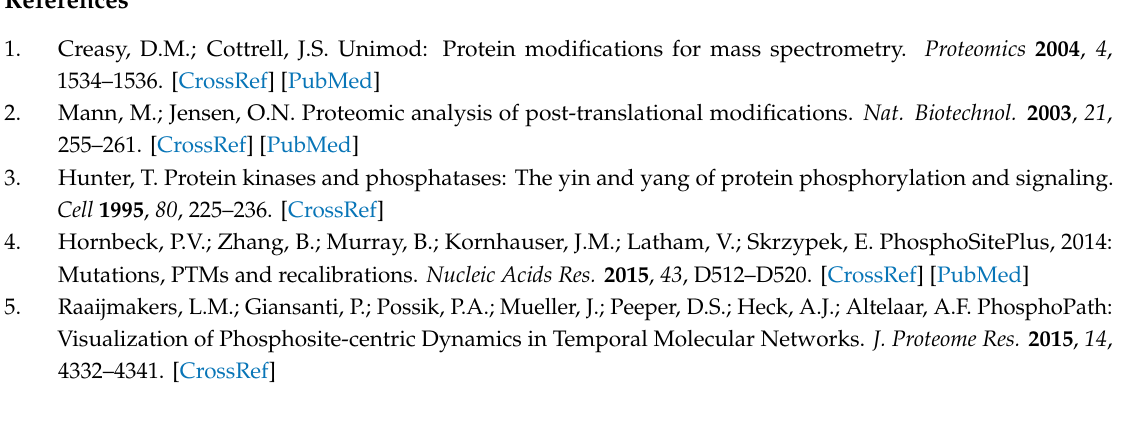
Supplementary Table S1: The proteomic data on the ubiquitinated peptide counts regarding thirteen human cancer cell lines, Supplementary Table S2: The proteomic data on the acetylated peptide counts regarding thirteen human cancer cell lines. Supplementary Table S3: The list of the proteins with dually modified lysine residues identified from each cancer cell